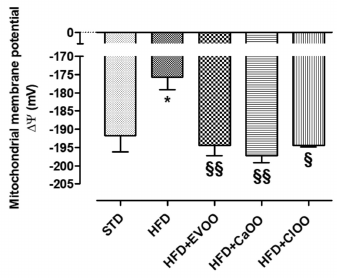
Figure 6. Changes in mitochondrial membrane potential in di ff erent animals. * indicates a statistically significant di ff erence between the HFD group and the STD group. § indicates statistically significant di ff erence between HFD and HFD + CEVOO or HFD + Ca OO or HFD + Cl OO. Single symbol corresponds to p < 0.05; double symbol to p <